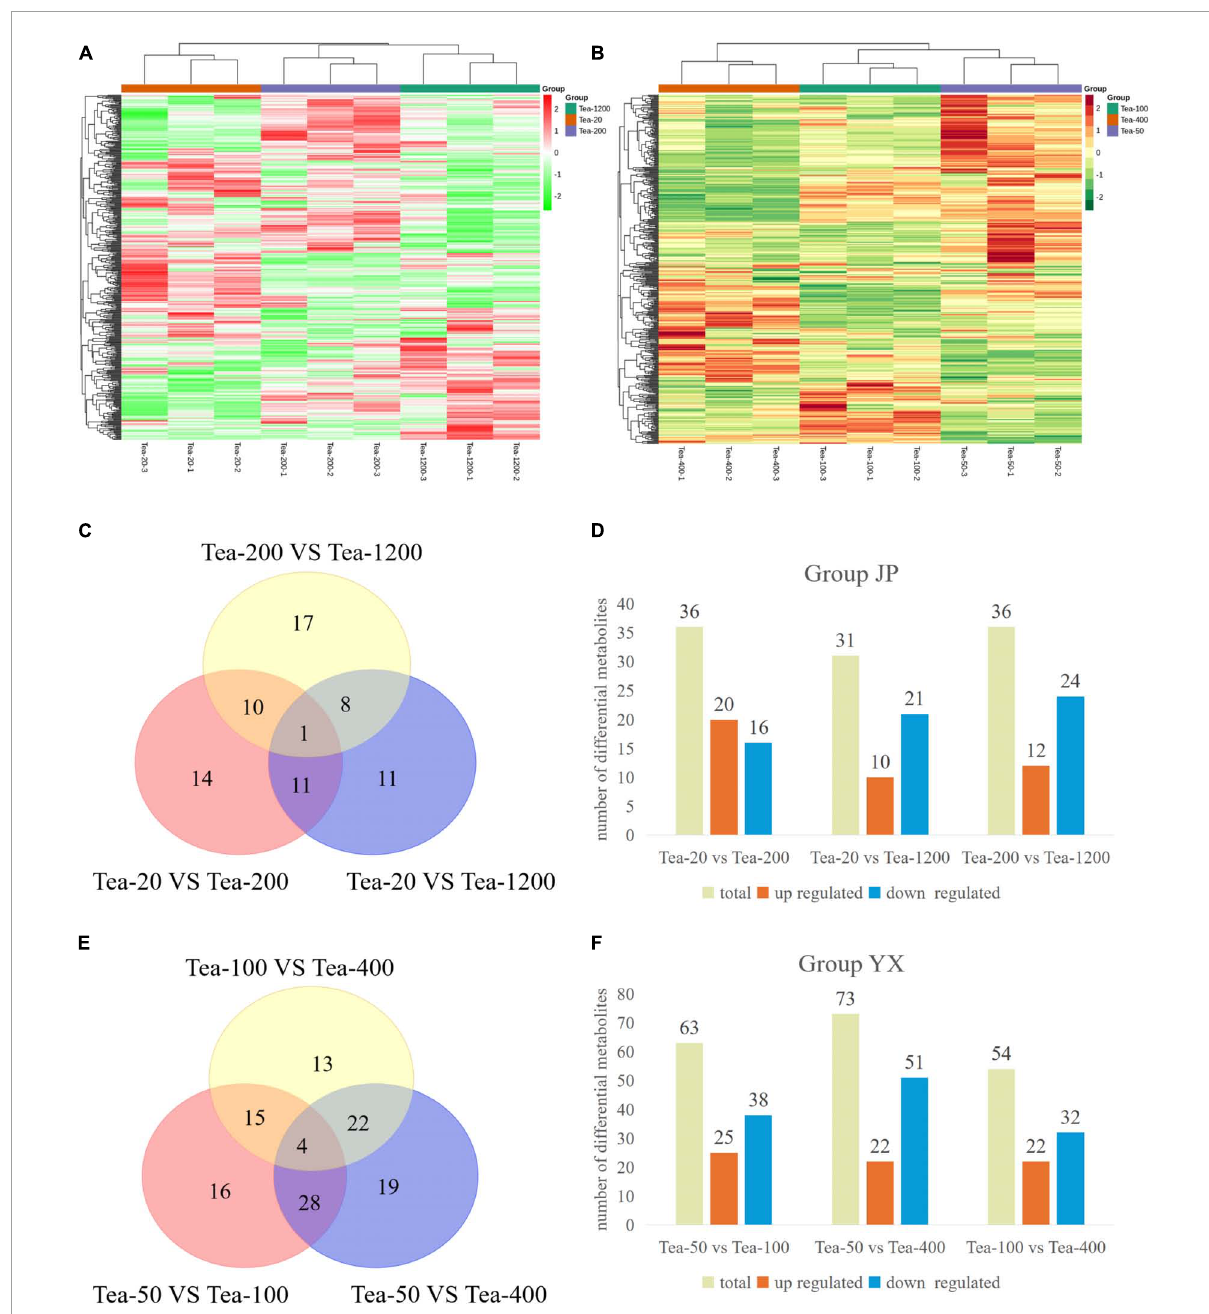
FIGURE8 (A,B) Cluster heat map and (C–F) statistical map of differential metabolites of fresh leaves of trees of different ages.